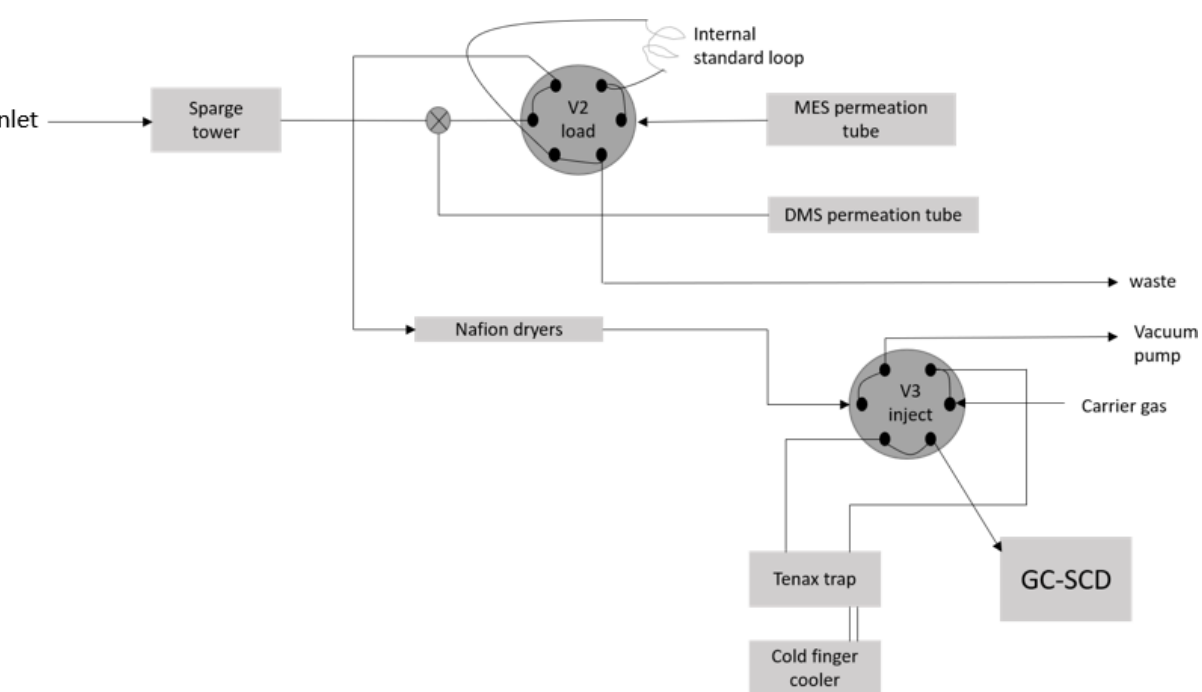
Figure 5. A schematic layout of the DMS analysis system for measuring dissolved DMS, including the sparge tower, internal and external standards, Nafion dryers, Tenax trap, and the GC-SCD (not to